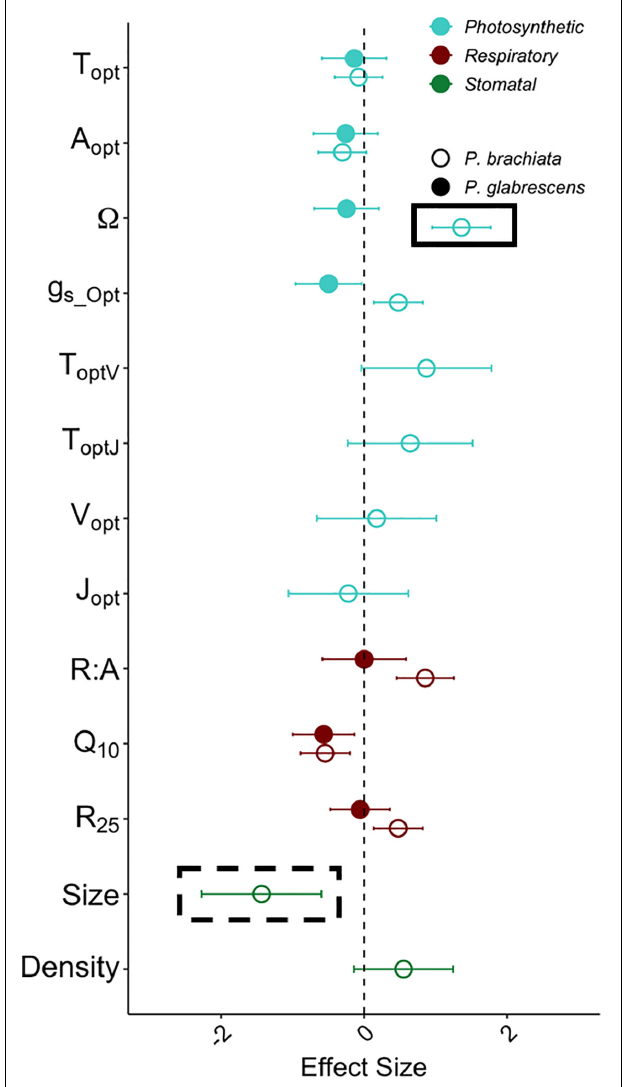
FIGURE 5 | Acclimation effect size with warming for the photosynthesis, respiration, and stomatal size and density variables. Variables represented are the optimum temperature of photosynthesis ( T opt ) ( ◦ C), the photosynthetic rate at T opt ( A opt ) ( µ mol m − 2 s − 1 ), the width of the photosynthetic – temperature response curve ( (cid:127) ) ( ◦ C), the rate of stomatal conductance at T opt (g s_Opt ) (mol m − 2 s − 1 ), optimum temperature of the maximum rate of Rubisco carboxylation ( T optV ) ( ◦ C), optimum temperature of the maximum photosynthetic electron transport ( T optJ ) ( ◦ C), rate of the maximum rate of Rubisco carboxylation at the optimum temperature ( V opt ) ( µ mol m − 2 s − 1 ), rate of maximum photosynthetic electron transport at the optimum temperature ( J opt ) ( µ mol m − 2 s − 1 ), respiration increase with every 10 ◦ C (Q 10 ), the rate of leaf dark respiration at 25 ◦ C ( R 25 ) ( µ mol m − 2 s − 1 ), the ratio between R 25 and photosynthesis at 25 ◦ C ( R:A ), stomatal density (Density) (m m − 2 ) and stomatal size (Size) ( µ m 2 ). Colors of data points depict the variable type, where light blue represents photosynthetic variables, dark red represents dark respiration variables, and green represents stomatal size and density. Symbols depict whether the sample is Psychotria brachiata (open) or Piper glabrescens (closed). Black boxes around P. brachiata (cid:127) and stomatal size indicate significant (solid box) or marginally significant (dashed box) acclimation as calculated through the gain score analysis. Error bars depict variance of effect size as calculated from Gurevitch et al.